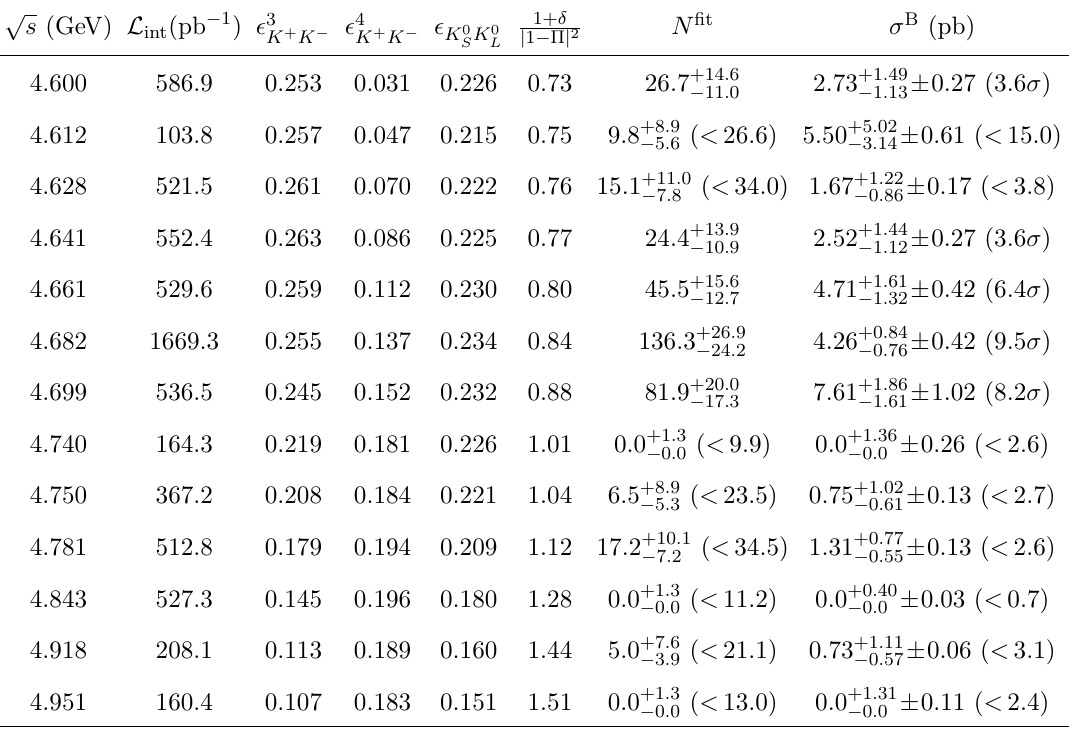
√ Table 2 . The Born cross section σ B for e + e − → φχ c 2 at each c.m. energy ( s ). The numbers in the brackets are the signal significances or upper limits σ U . L . at the 90% C.L. in case the signal significance is less than 3 σ . The table also includes integrated luminosity L int , detection efficiency (cid:15) 3 , (cid:15) 4 and (cid:15) for the 3-track events of the φ → K + K − mode, 4-track events of the K 0 K 0 K + K − K + K − S L φ → K + K − mode and the events of the φ → K 0 K 0 mode, respectively, the product of radiative S L correction factor and vacuum polarization factor 1+ δ and the number of fitted events N fit (also | 1 − Π | 2 the corresponding upper limit N U . L . at the 90% C.L. in case the signal significance is less than 3 σ ). The first uncertainty is statistical and the second is systematic.